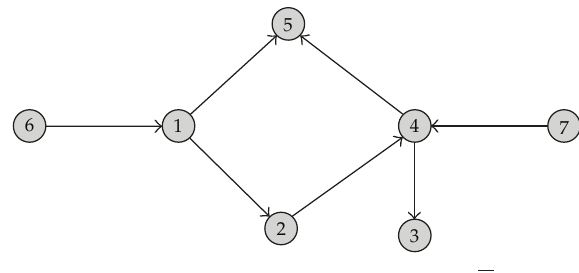
Figure 1: The communication topology G